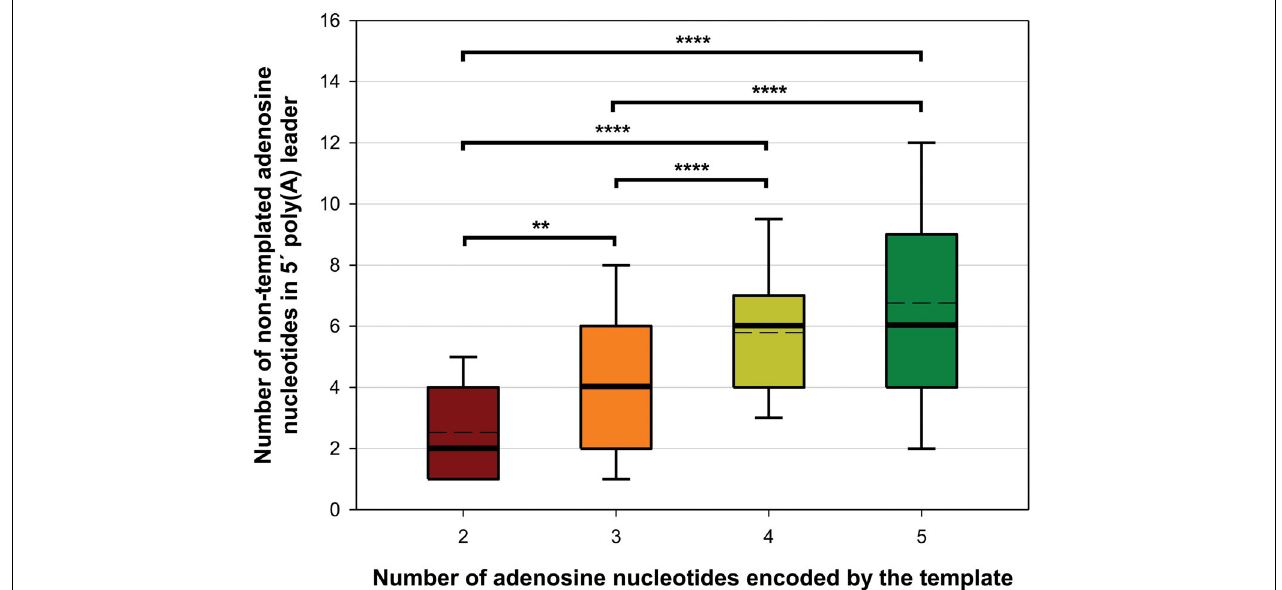
FIGURE 6 | The number of 5 (cid:48) non-templated adenosine nucleotides in the 5 (cid:48) leaders of pGKL transcripts increases with the number of adjacent consecutive adenosines encoded by the template. The box whisker plot represents the number of non-templated adenosine nucleotides in the 5 (cid:48) poly(A) leaders of pGKL mRNAs classified according to the length of the adjacent consecutive adenosines encoded by the DNA template at the TSS. The bottom and top of the box indicate the first and third quartiles, respectively. The whiskers indicate the 10th and 90th percentiles. The median and mean are indicated as bold and dashed lines, respectively. Outliers are not indicated. Two adenosines are encoded in the TSS of the K2ORF8 promoter (red). Three adenosines are encoded in the TSS of the K1ORF4 , K2ORF1 , K2ORF5 , K2ORF9 , and K2ORF11 promoters (orange). Four adenosines are encoded in the TSS of the K1ORF2 , K2ORF6 , and K2ORF10 promoters (yellow). Five adenosines are encoded in the TSS of the K1ORF1 , K1ORF3 , K2ORF4 , and K2ORF7 promoters (green). The results suggest pGKL RNA polymerase slippage at the TSS as a mechanism of 5 (cid:48) mRNA poly(A) leader synthesis. The data did not follow a normal distribution according to the Shapiro–Wilk test. The results were statistically analyzed using a non-parametric Kruskal–Wallis test followed by a post hoc Dunn test with p -value adjustment according to the Benjamini–Hochberg FDR method. Adjusted p -values corresponding to all possible pairs are depicted in Supplementary Table S11 . ∗∗ Significance level p < 0.01; ∗∗∗∗ significance level p < 0.0001. In total, 373 sequences obtained by 5 (cid:48) RACE-PCR containing non-templated adenosine nucleotides were used for this analysis ( Supplementary Table S8